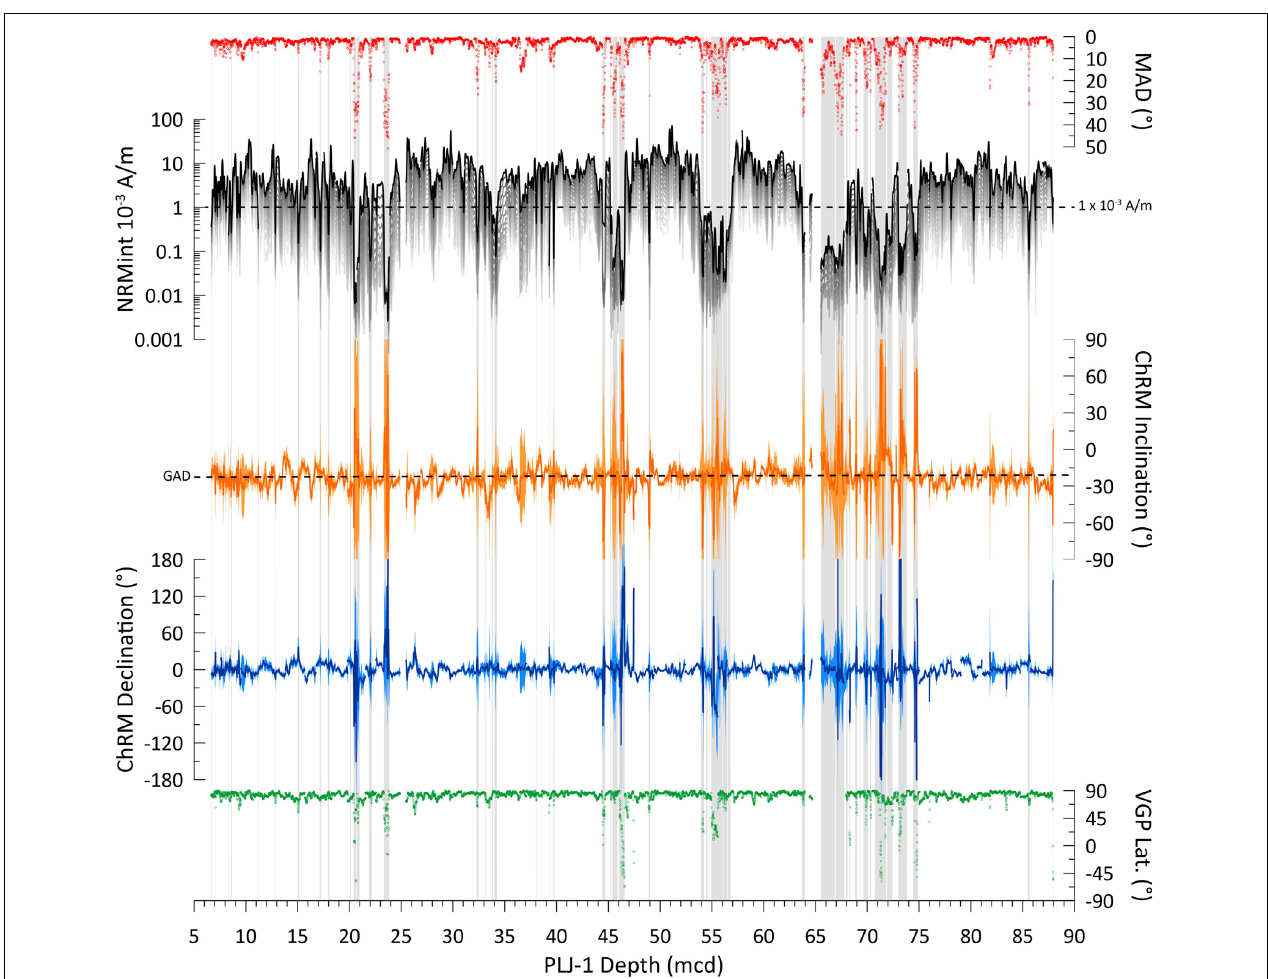
FIGURE 6 | Maximum angular deviation (MAD) values (red points), NRM intensity before (black data) and through progressive AF demagnetization (gray data), component inclination (orange) compared against a predicted value assuming a GAD and corrected (rotated to core mean of zero) component declination (blue), and virtual geomagnetic pole latitude (green points). a95 directional uncertainties (colored shading around the inclination and declination values) are calculated from MAD values using the method of Khokhlov and Hulot (2016). Gray vertical shading denotes NRM 0 mT intensity values below a 1 × 10 - 3 A/m threshold. Note the higher MAD values, greater directional variability, uncertainty, and VGP latitude scatter with lower than threshold NRM 0 mT intensity